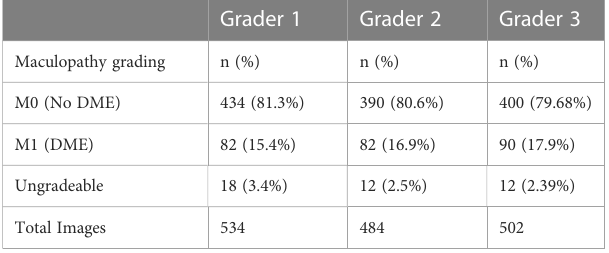
TABLE 2 Diabetes macula oedema staging by the 3 levels of